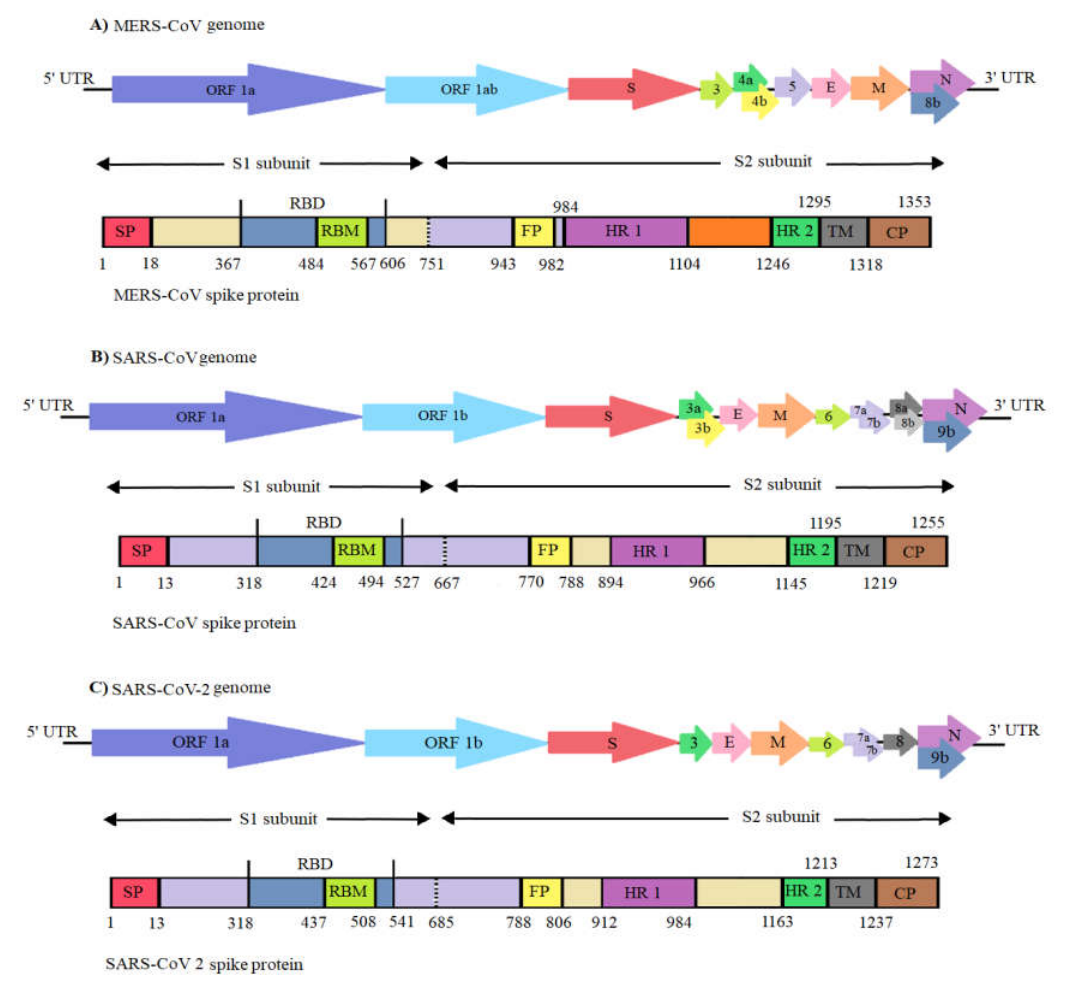
Fig 1. Schematic organization of the MERS-CoV, SARS-CoV, and SARS-CoV-2 RNA genomes: From the 5′ of the genome, there are two large open reading frames (ORF1a and ORF1b) which are highly conserved between coronaviruses and encode two long polyprotein precursors, pp1a and pp1ab, respectively; The remaining 3′ of the genome coding four structural proteins, spike (S), envelope (E), membrane (M), and nucleocapsid (N), along with a set of nonstructural proteins; The structure of each CoV spike protein contains S1 and S2 subunits, indicated below each genome. CP= Cytoplasm domain, FP= Fusion peptide, HR= Heptad repeat, RBD= Receptor binding domain, RBM= Receptor binding motif, SP= Signal peptide, TM= Transmembrane